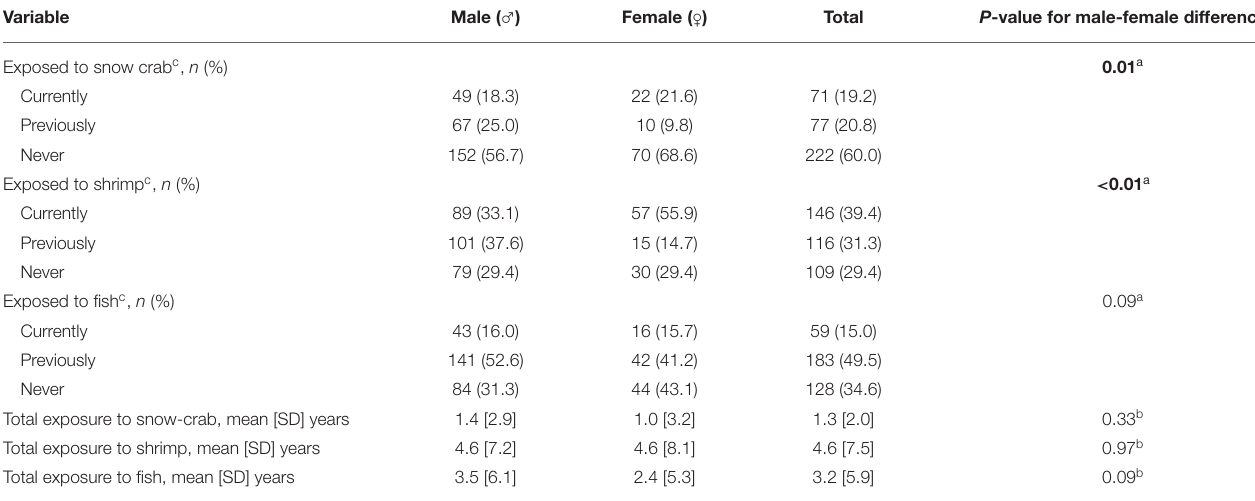
TABLE 2 | Exposure characteristics of the study population.